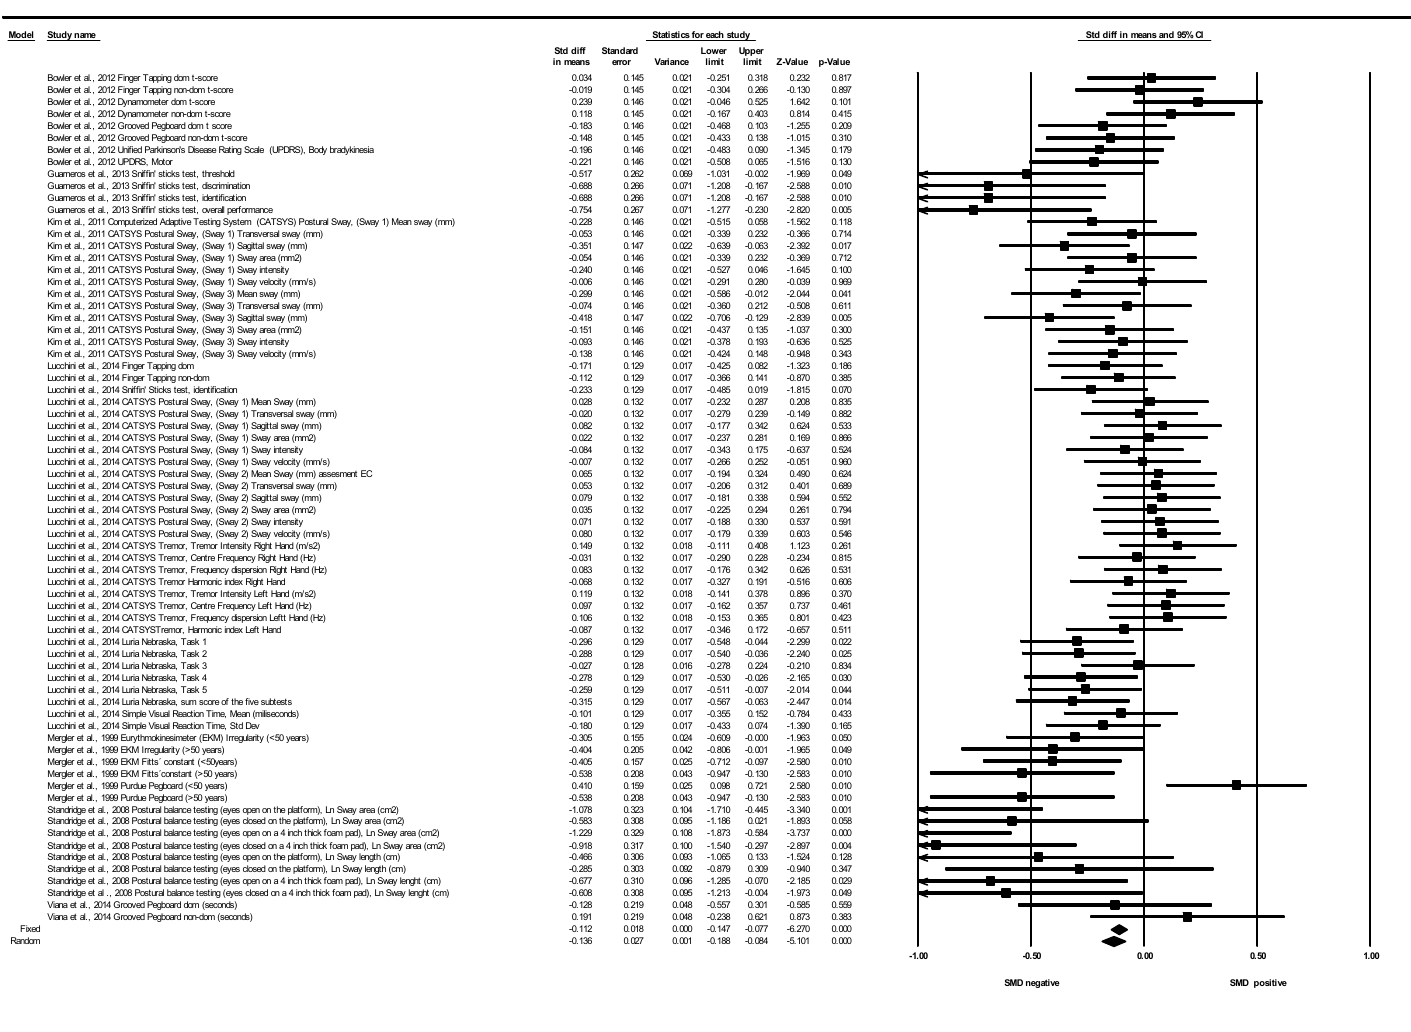
Figure 5. Motor function. Standardized mean differences (SMDs) between groups. All tests and all exposures to Mn. Note: a negative SMD indicates that the group with higher Mn levels had worse motor function on average.